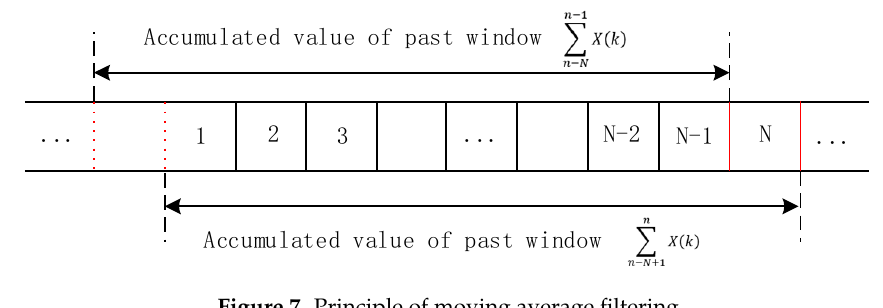
Figure 7. Principle of moving average filtering.